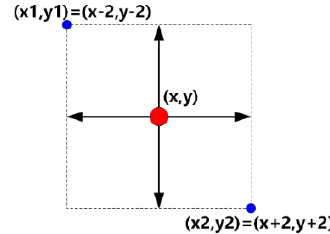
Figure 5. The bounding box generated from the given target coordinates.